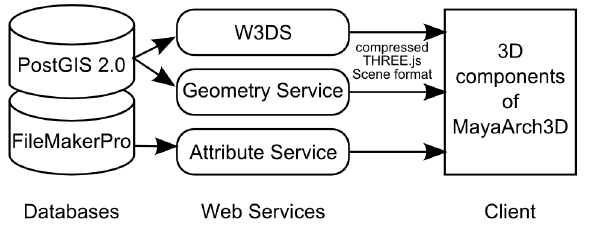
Figure 4. Compressed transmission of segmented models from PostGIS 2.0 database via web services to the 3D components of MayaArch3D